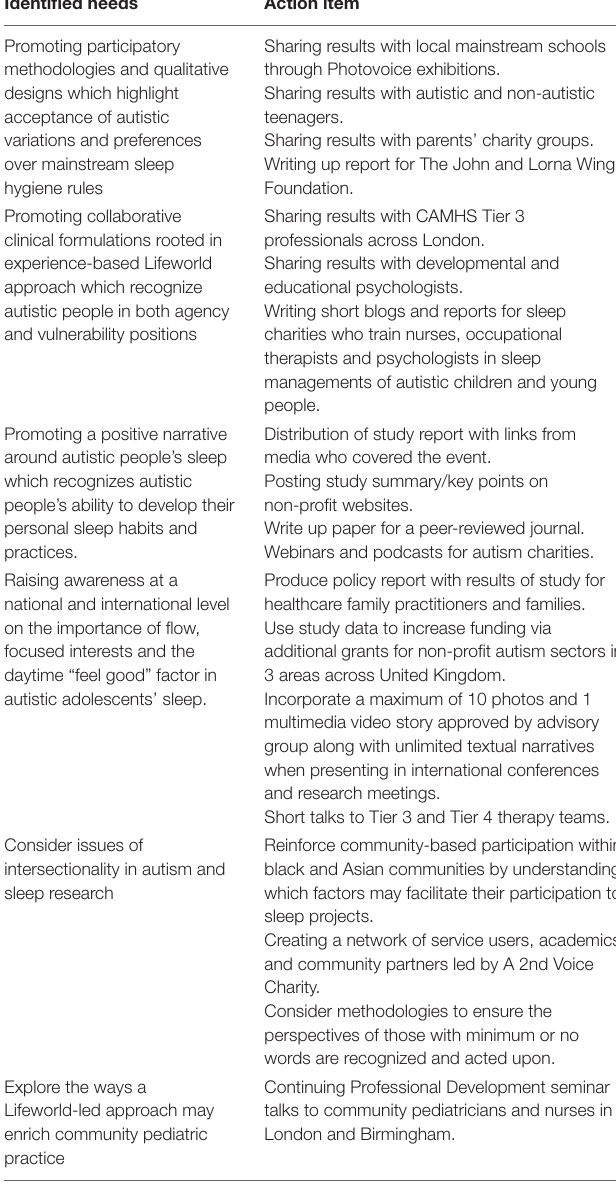
TABLE 7 | Train and Engage overview of post study